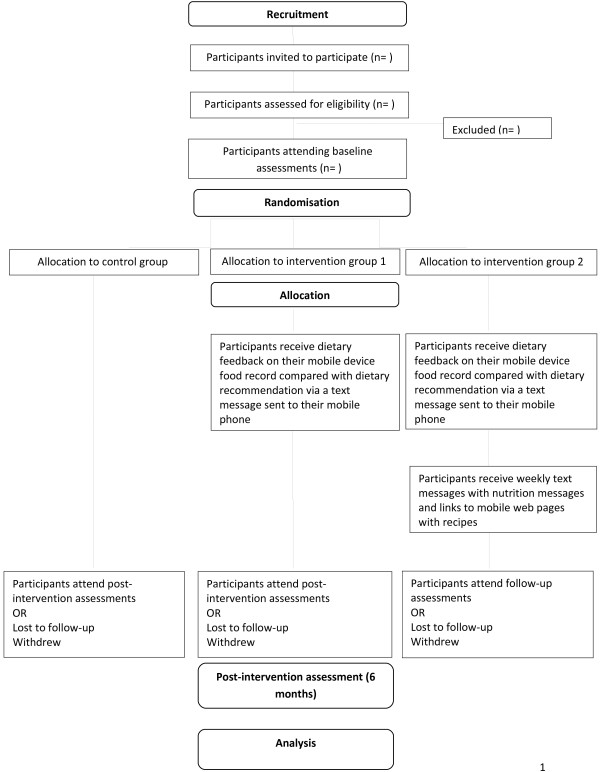
CHAT study design.